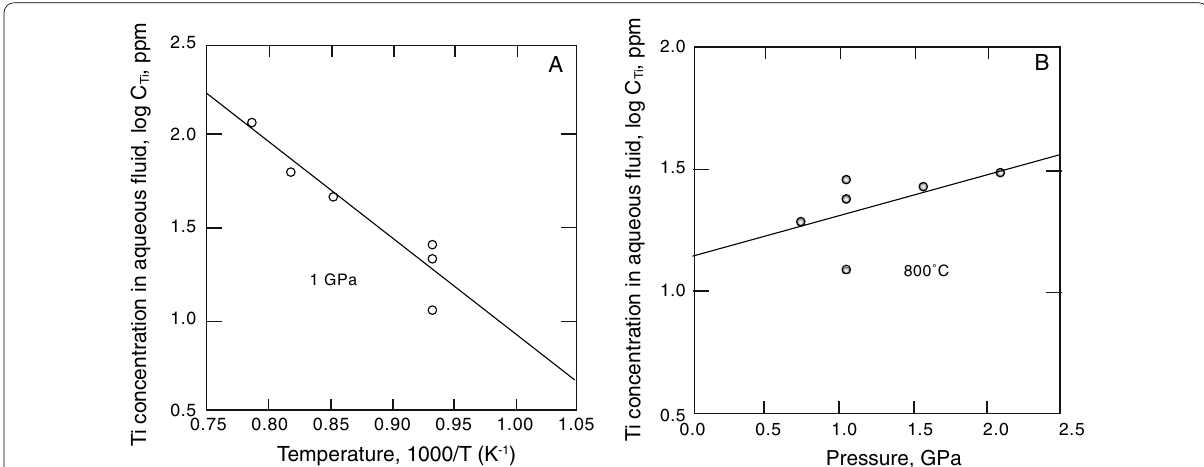
Fig. 24 Titanium concentration in in aqueous fluid in equilibrium with rutile in the system TiO 2 –H 2 O A . as a function of temperature at 1 GPa pressure, and B . as a function of pressure at 800 °C Modified after Antignano and Manning